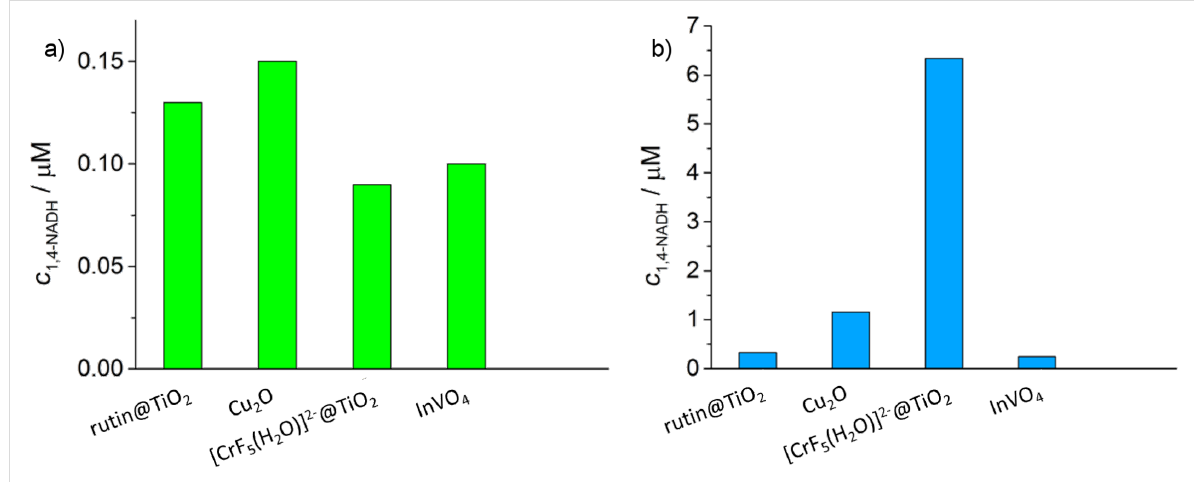
Figure 3: a) Photoregeneration of 1,4-NADH using water as an electron donor: after 6 hours of irradiation of the NAD + /water solutions in the pres- ence of various photocatalysts. b) Photoregeneration of 1,4-NADH using several photocatalysts, and [Cp*Rh(bpy)H 2 O]Cl 2 as an electron mediator or